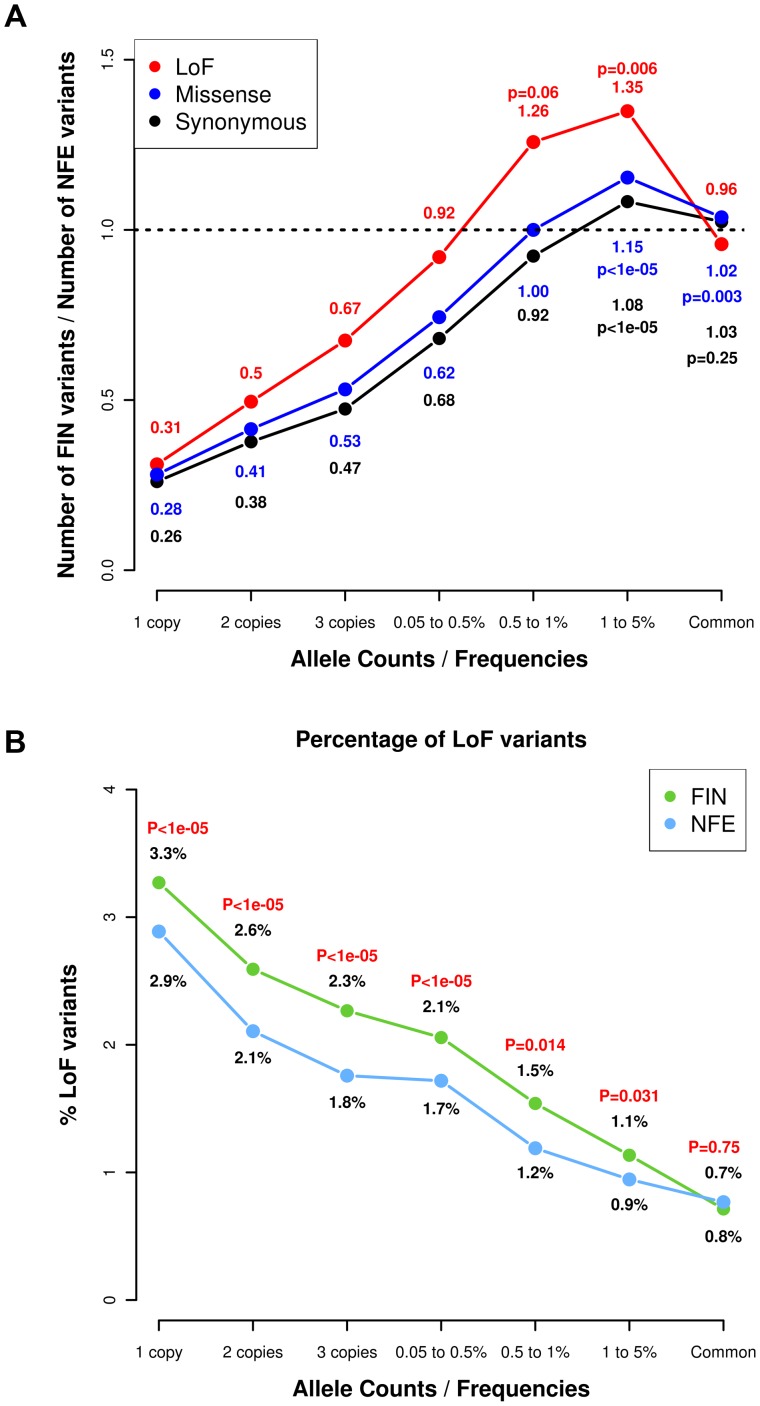
Allele frequency spectrum in Finns and NFEs, demonstrating that Finns have proportionally more deleterious rare and low-frequency variants.(A) Ratio of the number of LoF, missense and synonymous variants found in Finns versus NFEs with the ratios for LoF variants highlighted in red text and the ratios for synonymous variants in black. The p-values represent the probabilities of the excess of variable sites in Finns occurring by chance. The p-values in red represent the probabilities for the LoF variants, the p-values in blue represent the probabilities for the missense variants and the p-values in black represent the probabilities for the synonymous variants. (B) Percentage of variants that are LoF across the allele frequency spectrum, with the numbers indicating the percentage of LoF variants in Finns versus NFEs. The p-values represent the p-values from the hypergeometric test of whether the ratio of LoF variants differ from the ratio of synonymous variants in Finns compared to NFEs.